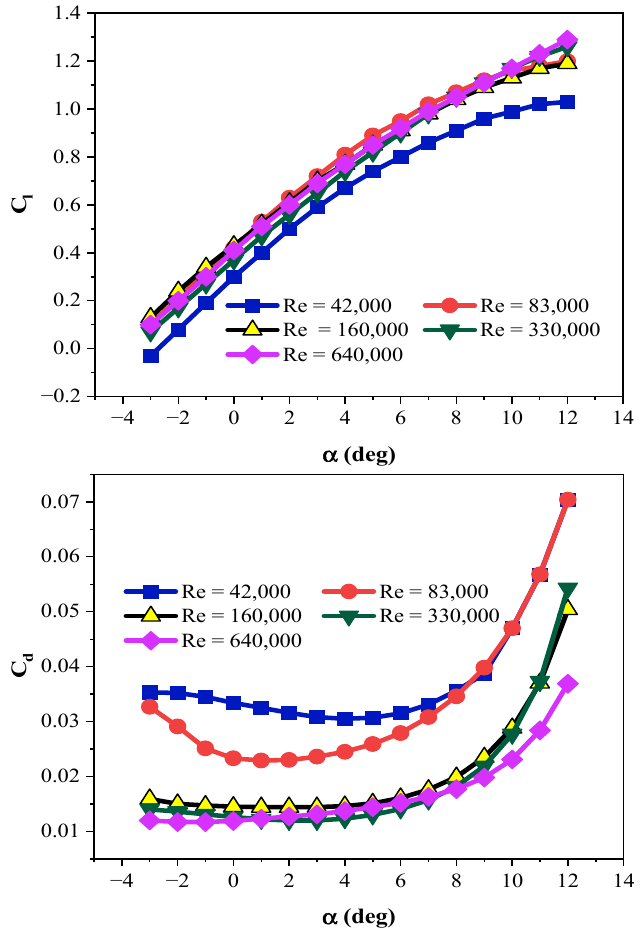
Figure 5. The variations in the drag and lift coefficients of the NACA4412 profile [10].